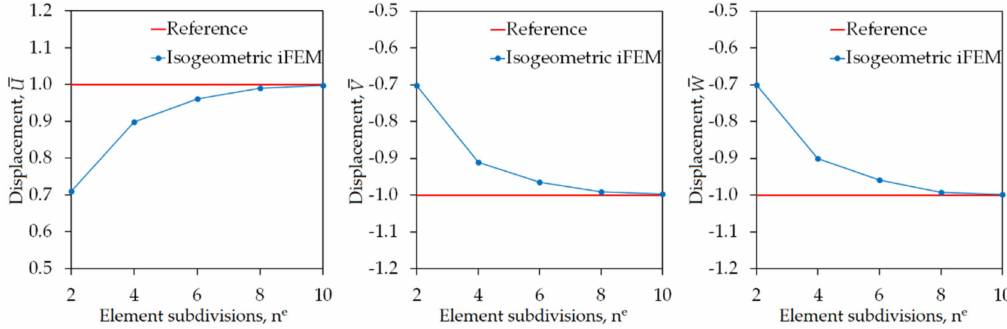
Figure 14. Convergence of maximum values of U , V , W displacements, versus increasing number of element subdivisions n e for hyperbolic paraboloid.